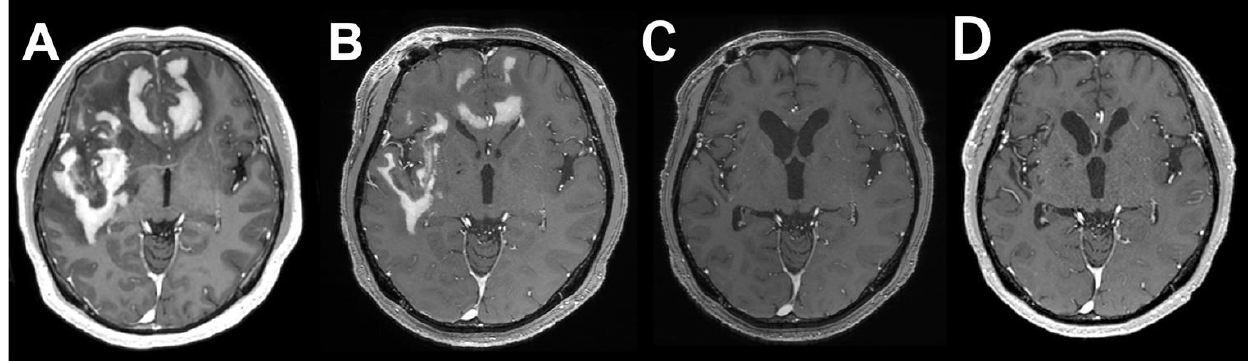
Figure 2. ( A , B ) Histopathological examination revealed perivascular and diffuse distribution of rel- atively large lymphoma cells and smaller reactive lymphocytes (hematoxylin–eosin staining). ( C ) The large cells were positive for CD20. ( D ) The tumor cells were highly positive for SLFN11, sug- gesting sensitivity to chemotherapy. Scale bar = 80 μm ( A ), 20 μm ( B ), 40 μm ( C , D ). Intravenous dexamethasone was started at a dose of 16 mg/day and tapered. Subse-